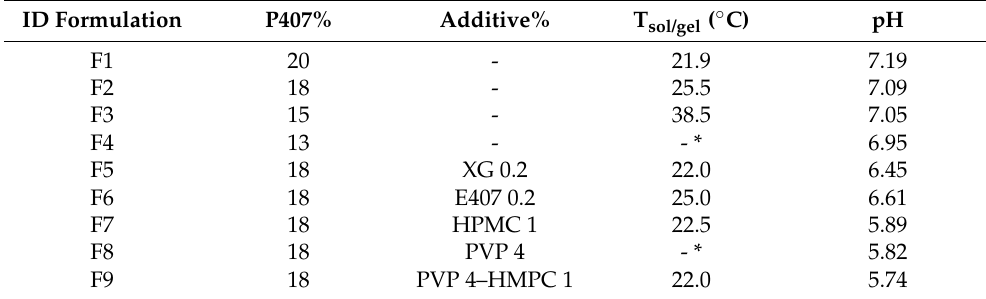
Table 1. T sol-gel and pH of P407 formulations with additives prepared in ultrapure water.